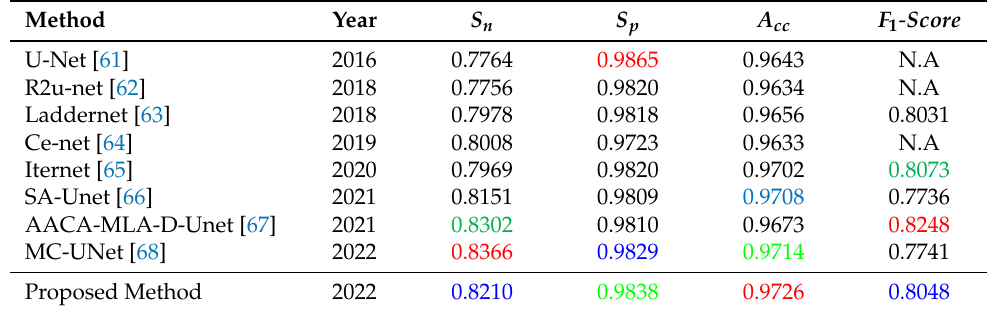
Table 3. Comparison results on the CHASE dataset. Red is the best, green is the 2nd best, and blue is the 3rd